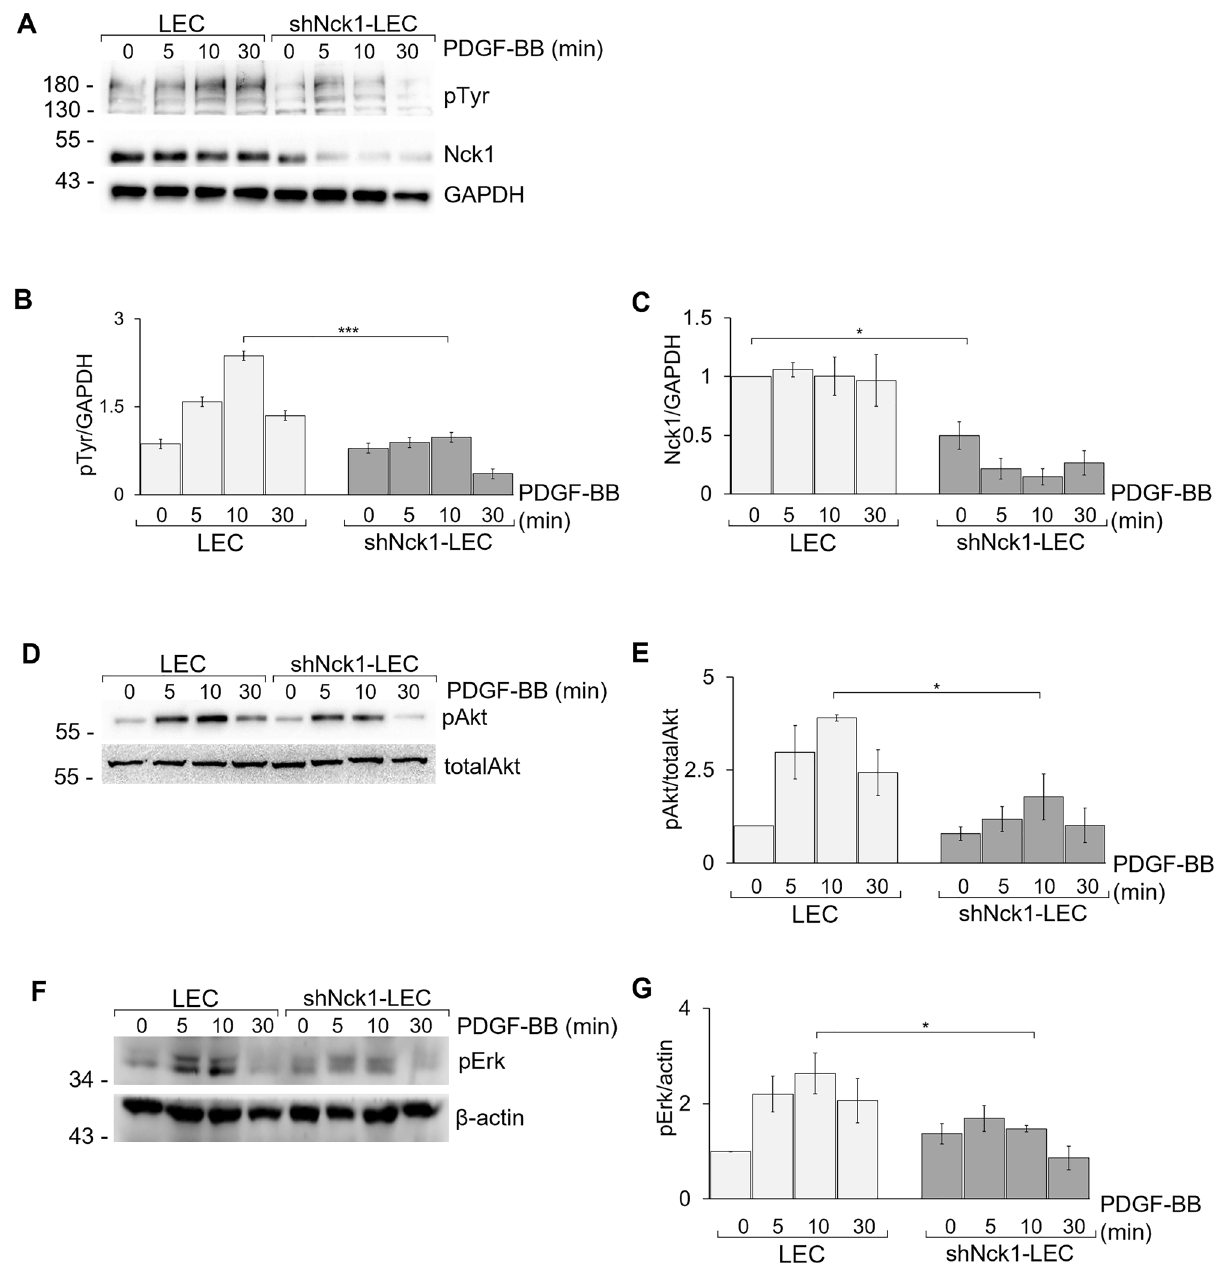
Figure 6. Nck1 knockdown impaired PDGFR-mediated signaling pathway. LEC and shNck1 LEC were either stimulated with 30 ng/ml PDGF-BB or left untreated at 37 °C for the indicated times. Cell lysates were separated by SDS-PAGE and the western blot was probed with ( A , B ) anti-phospho-tyrosine (p-Tyr, 4G10), ( A , C ) anti-Nck1, ( D , E ) anti-phospho-Akt (pAkt) and ( E , F ) anti-phospho-Erk1/2 (pErk1/2) antibodies. The quantified signal intensities are presented as a ratio of the protein of choice to the corresponding GAPDH values normalized to the value of unstimulated LEC. Data are representative of three experiments (mean ± SEM). *p < 0.05, **p <